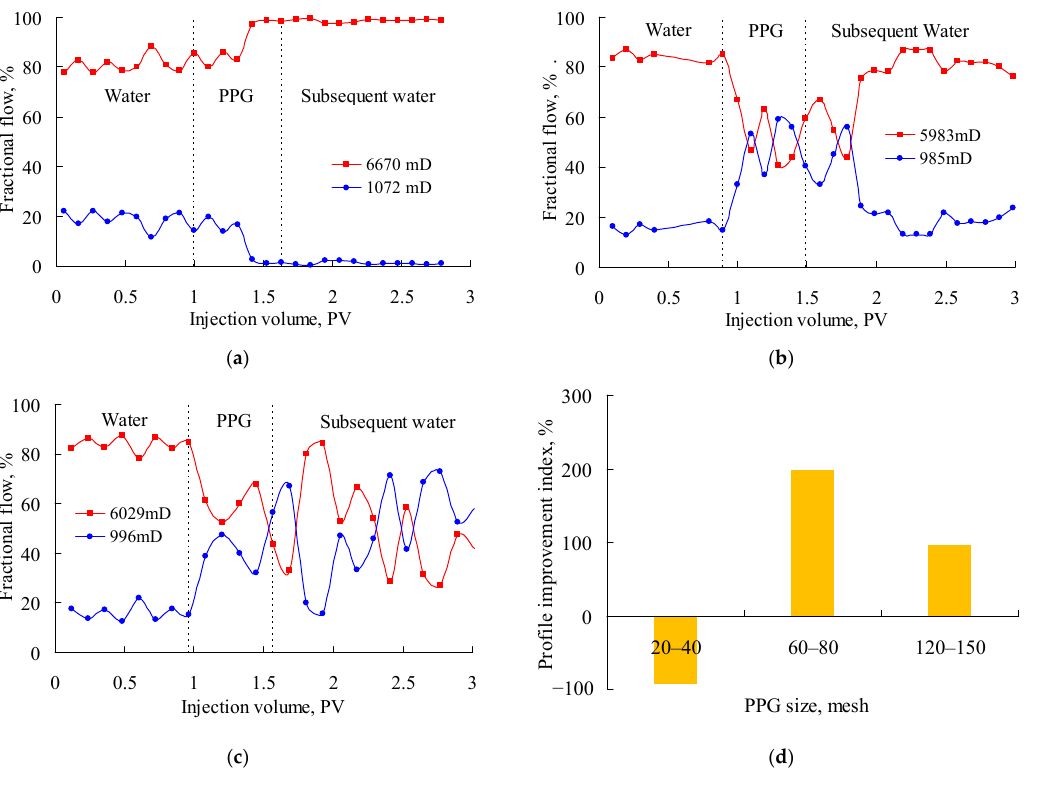
Figure 2. Fractional flow of parallel sand packs with permeability ratio of about 6 after injecting the PPG (2–4 Pa). ( a ) 20–40 mesh; ( b ) 120–150 mesh; ( c ) 60–80 mesh; ( d ) profile improvement index.